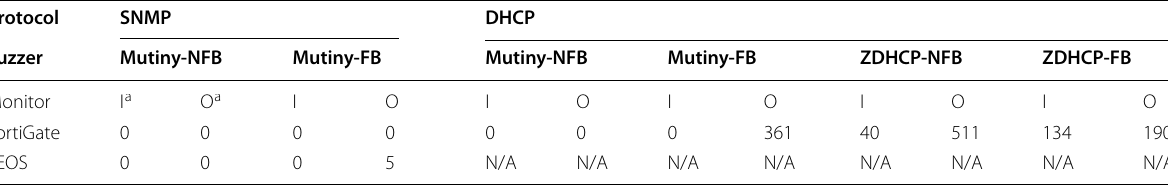
a I means In-VMM monitoring mechanism